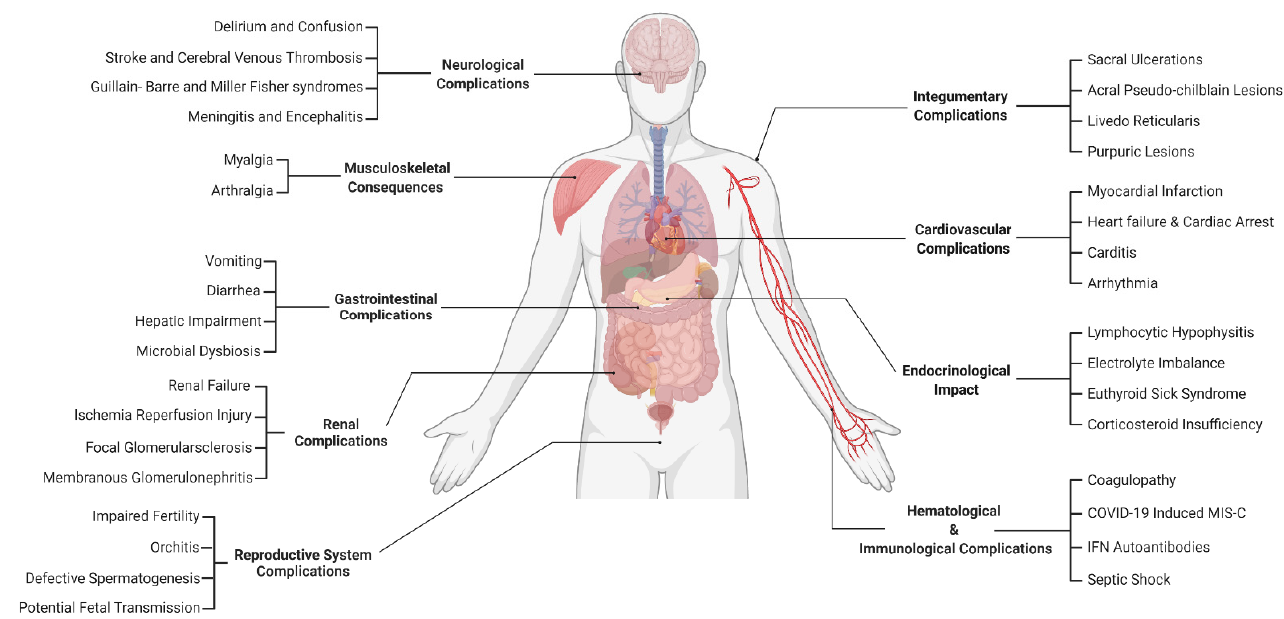
Figure 2. The potential extra-pulmonary complications of COVID-19 affecting multiple organ-systems [14–177]. Graphical contents were created with BioRender.com.